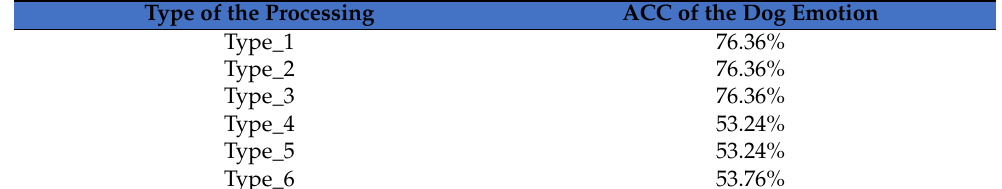
Table 18. Identi fi cation accuracy of model types in experiments conducted using AngryDogs data- set. Table 18. Identification accuracy of model types in experiments conducted using AngryDogs data-set.